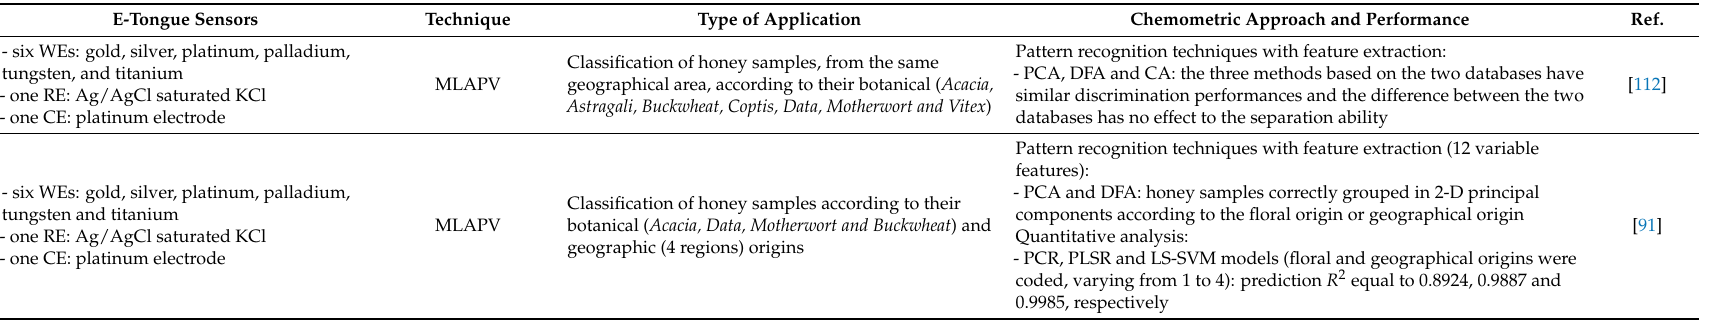
Table 5. Honey analysis using self-assembled lab-made multi-working electrodes voltammetric